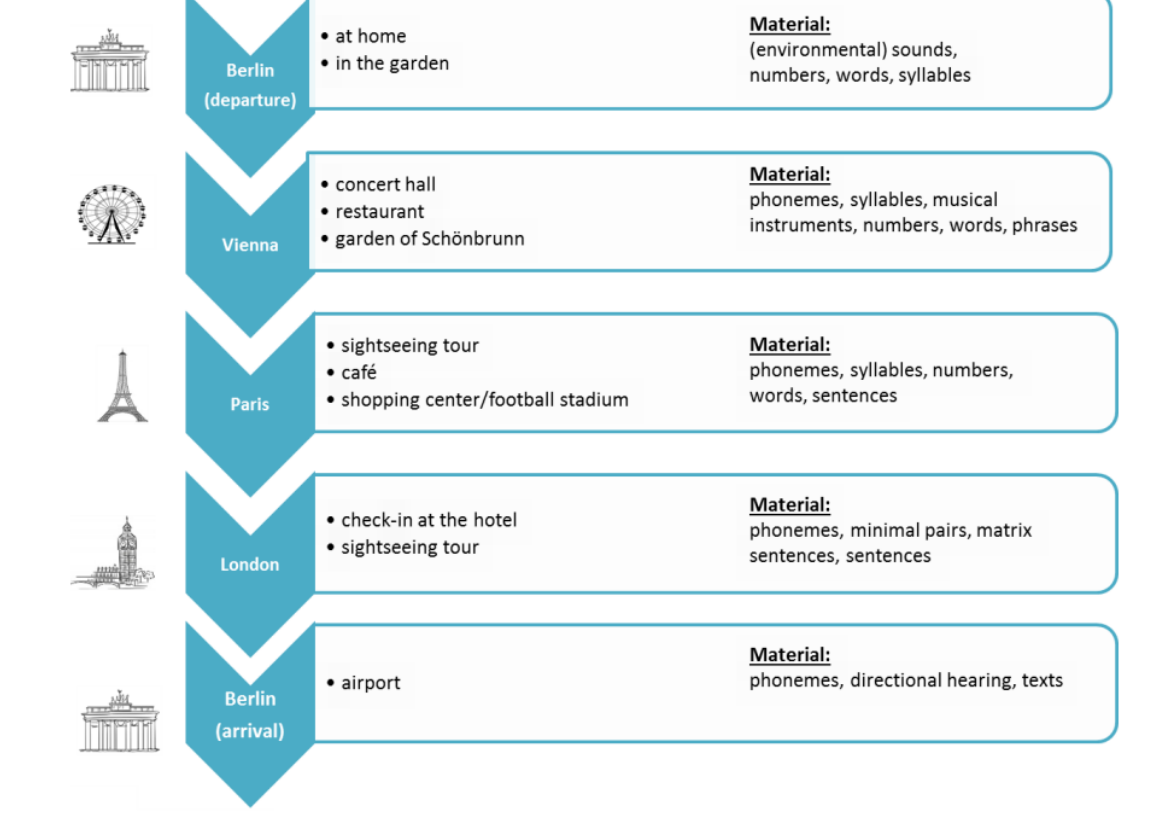
Figure 2. Overview of the training schedule during the Train2hear trip.